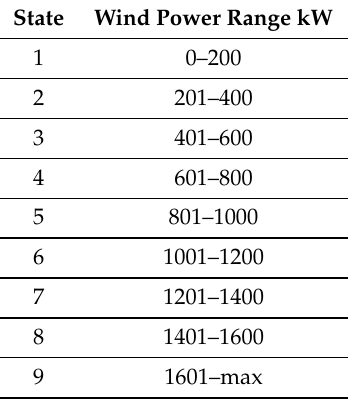
Table 2. Wind power discretization.